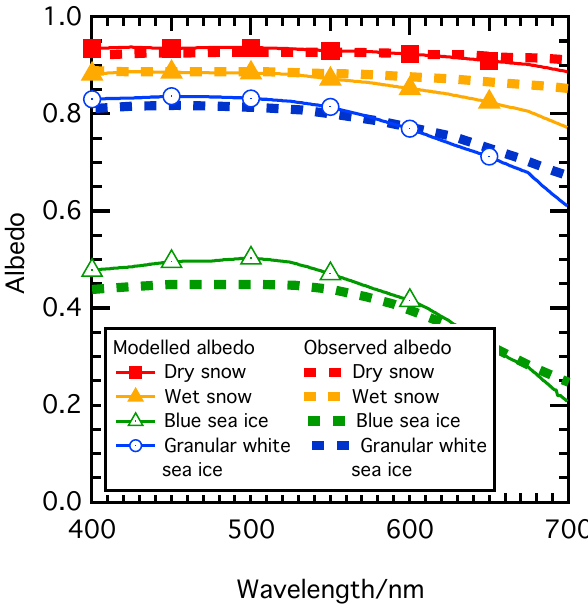
Fig. 5. Comparison of measured albedo by Grenfell and Maykut (1977) (dashed line) with albedo modelled in the study presented here (markers and solid